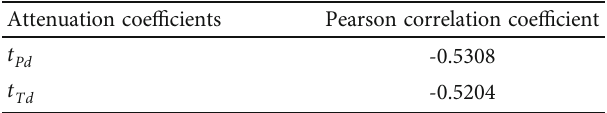
Table 4: Correlation analysis of max Mises stress. Attenuation coe ffi